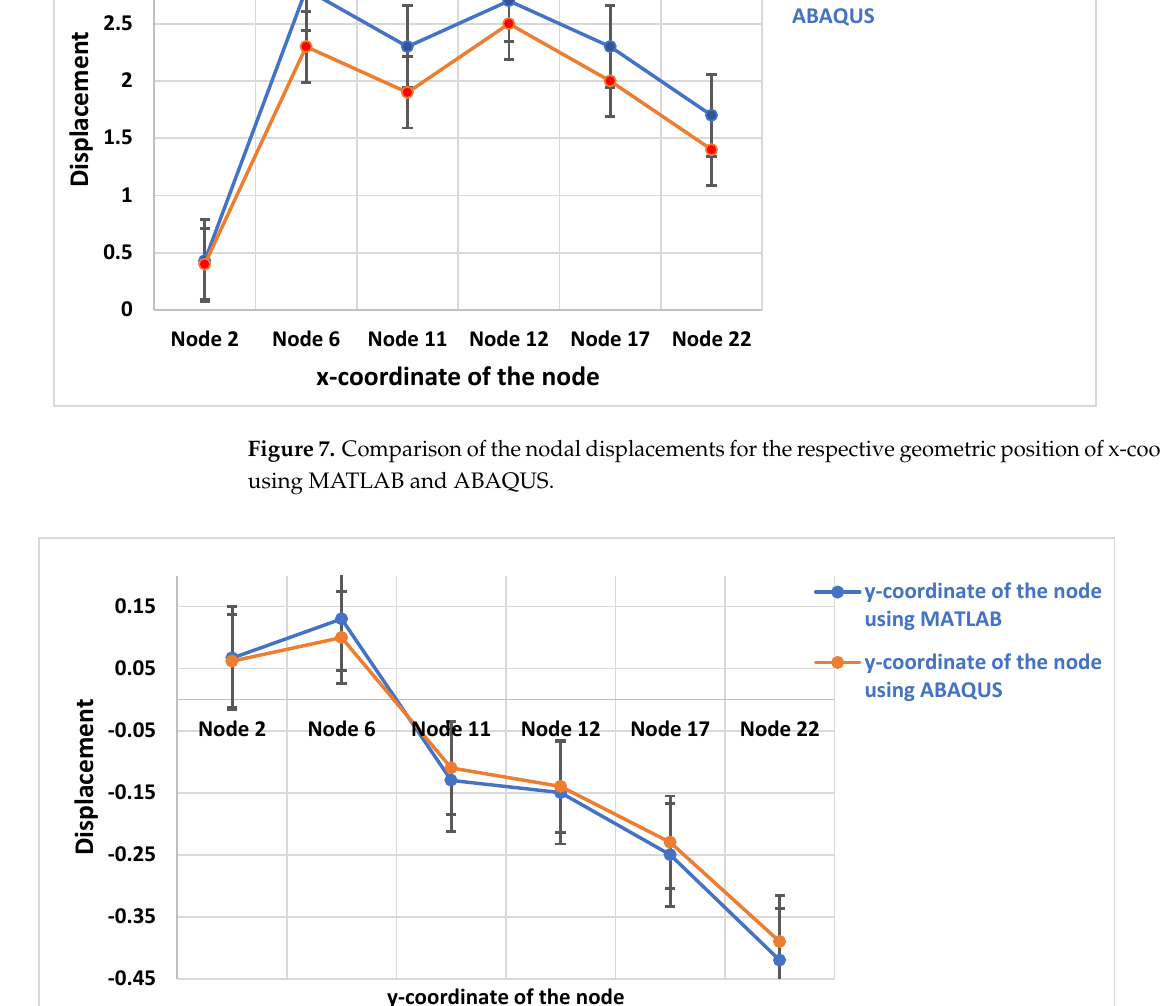
Figure 8. Comparison of the nodal displacements for the respective geometric position of y-coordinate using MATLAB and ABAQUS.